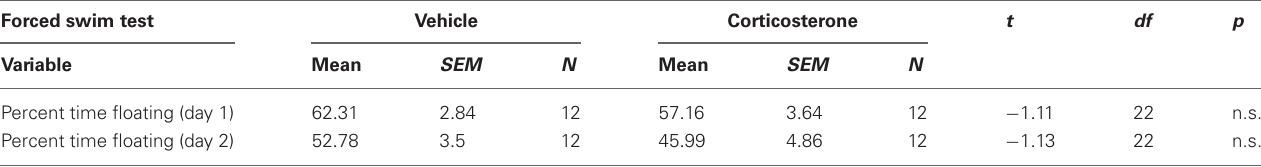
Table 2 | Effect of corticosterone or vehicle administration during peripuberty on depression-like behavior as evaluated in the forced swim test in